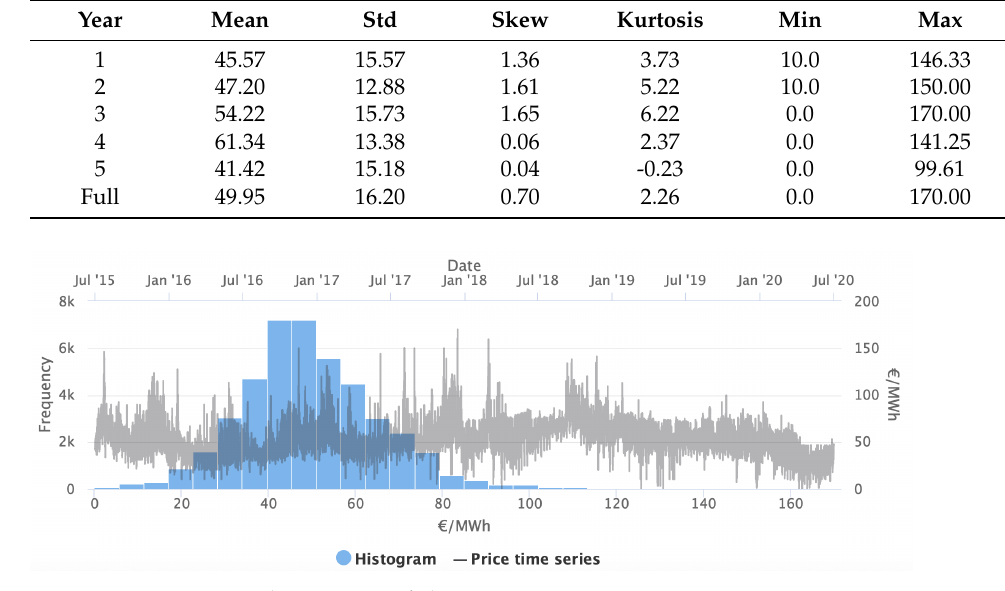
Figure 5. Histogram and time series of electricity